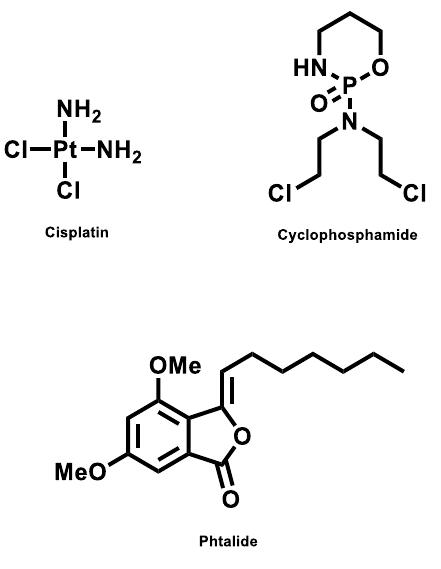
Figure 6. Structure of compounds. Table 6. Ligand – receptor complex interaction energies with B-DNA (crystallized).